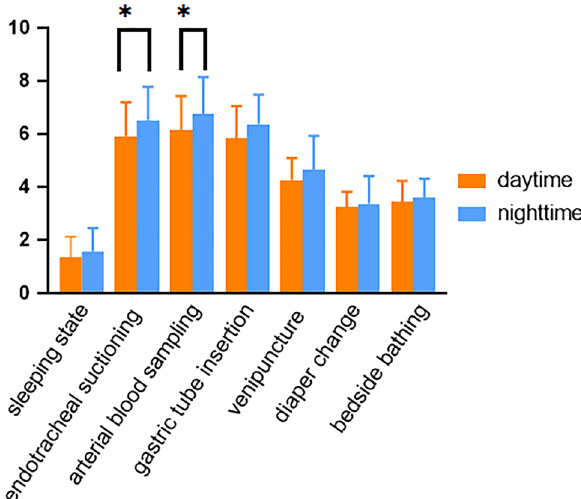
Figure 1. Comparison of daytime and nighttime salivary cortisol in neonates.